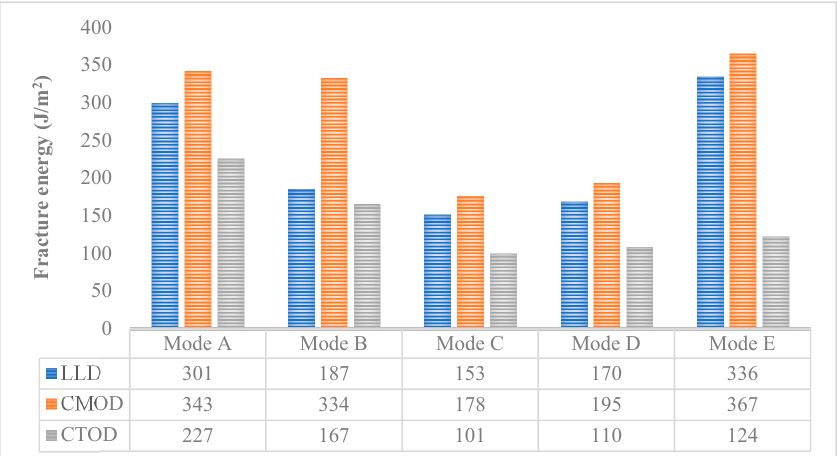
Figure 5. G f-LLD , G f-CMOD , and G f-CTOD of CR-20 mixture. The corresponding fracture angles of the CR-20 mixture under different mixed-mode levels (Mode A, Mode B, Mode C, Mode D, and Mode E) are 6°, 15°, 29°, 45°, and 50° respectively. It can be seen that the crack angle of CRM in the Arcan test has a clear rela- tionship with the mixed-cracking level. With the increase of the ratio of Mode II cracking, the crack angle of the CR-20 mixture will increase correspondingly. Therefore, according to the corresponding relationship between the crack angle and the mixed-cracking level in the Arcan test, the types of reflection cracking (tensile, shear, and mixed-mode) of the actual cold recycling pavement can be determined, so as to judge the failure stress mode of the actual pavement.